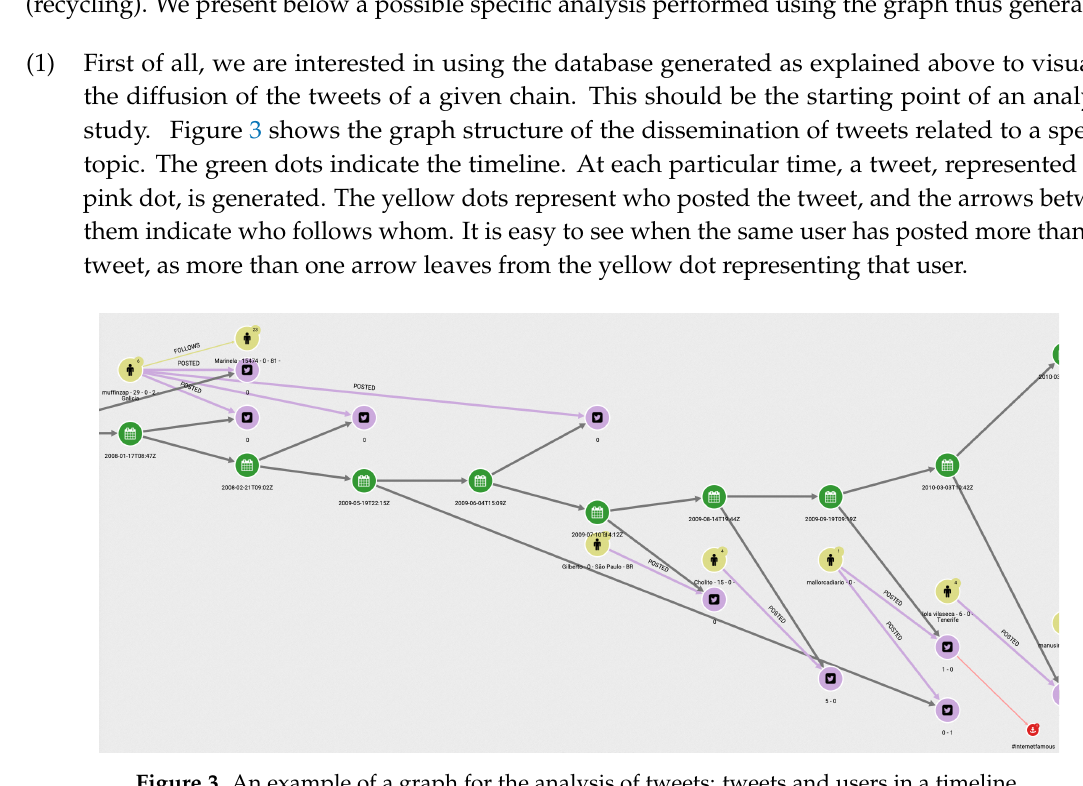
Figure 3. An example of a graph for the analysis of tweets: tweets and users in a